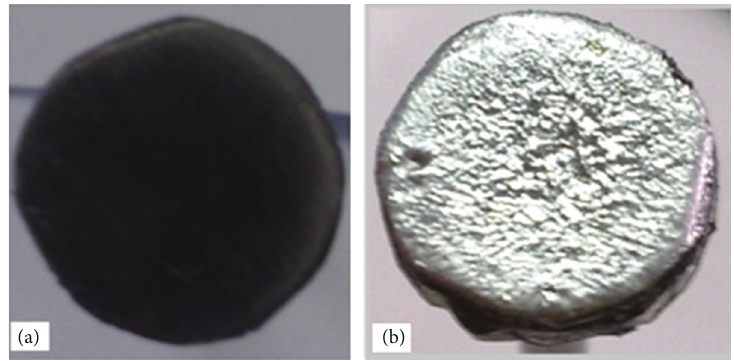
Figure 14: Images of the lead target (a) before and (b) after interaction with electron beam in the plasma focus.